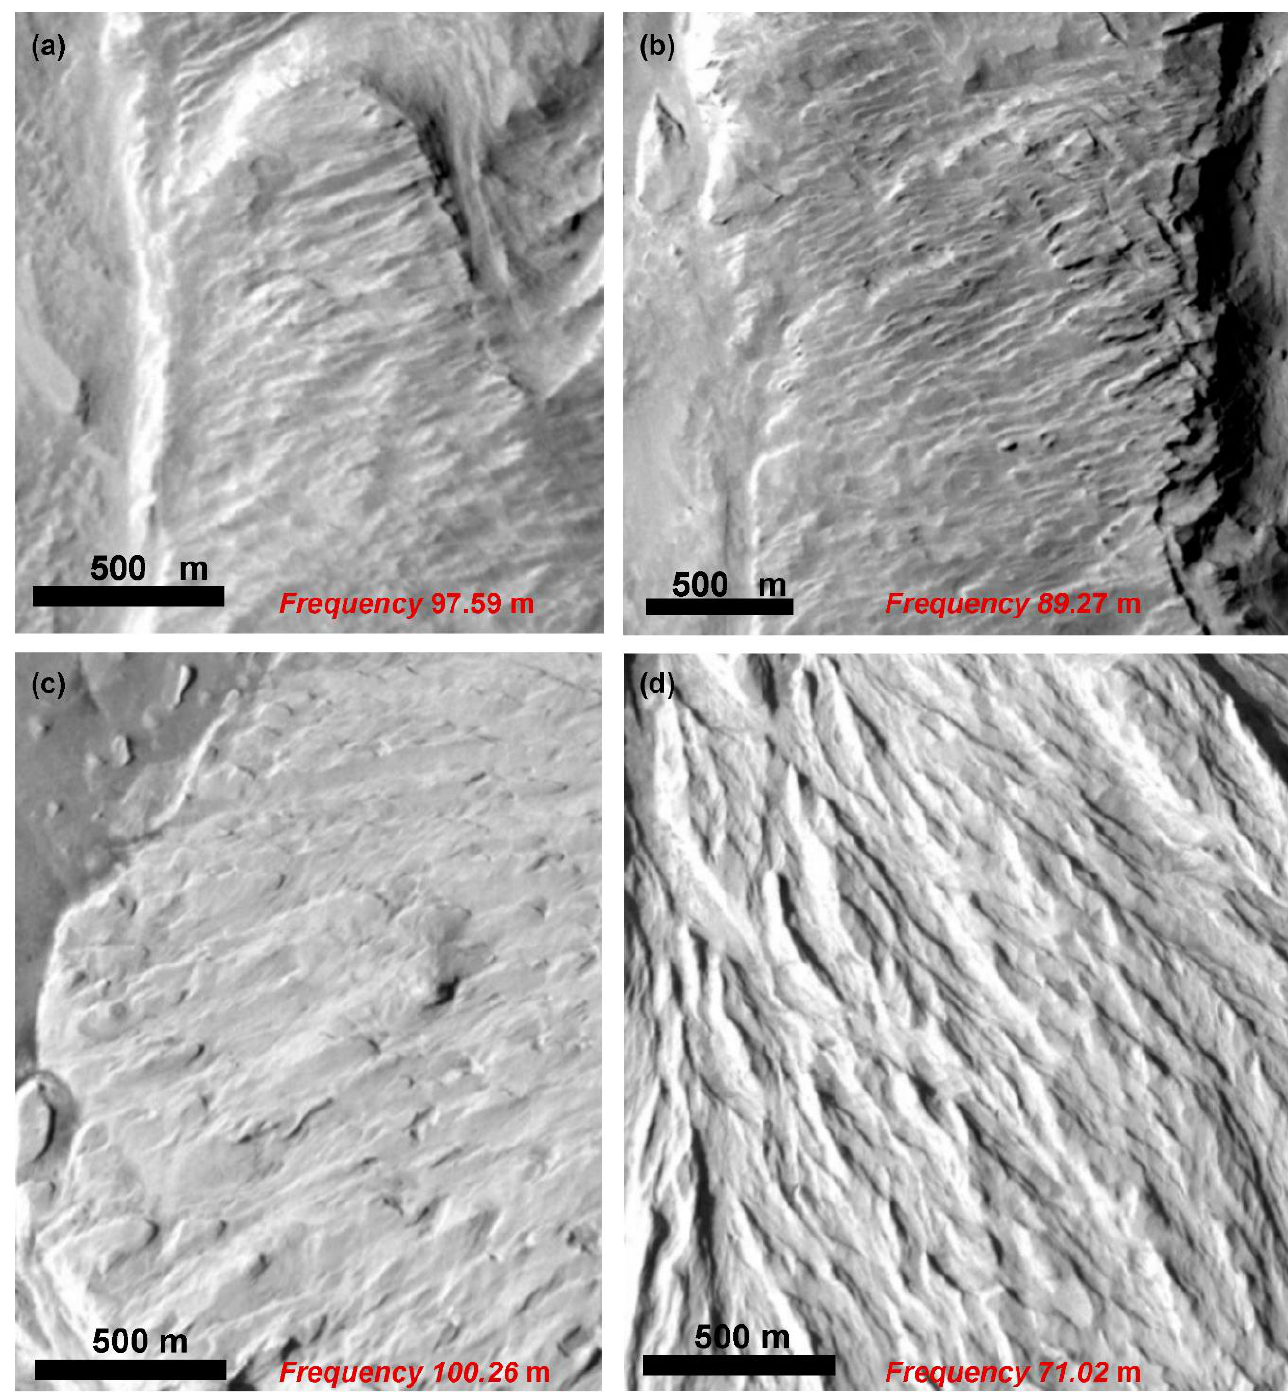
Figure 11. Lamented features examples on lobate feature complex and Mount Sharp light-toned unit. Frequency average of the two lobate features is 93.43 m and for the Mount Sharp light-toned units frequency averages are 91.94 m. ( a ) Detailed image of finely lamented features of the medial portion of the blue (3) lobe. Frequency of lamented features ~97.59 m on average; ( b ) Detail image of finely lamented features of the medial/distal portion of the red (1). Frequency of lamented features ~89.27 m on average; ( c ) detailed image of finely lamented features of the Light-Toned Yardang Unit (LTYu). Frequency of lamented features ~100.26 m on average; ( d ) detailed image of finely lamented features of Light-Toned Yardang Unit (LTYu). Frequency of lamented features ~71.02 m on average. Background image credit: NASA/JPL.